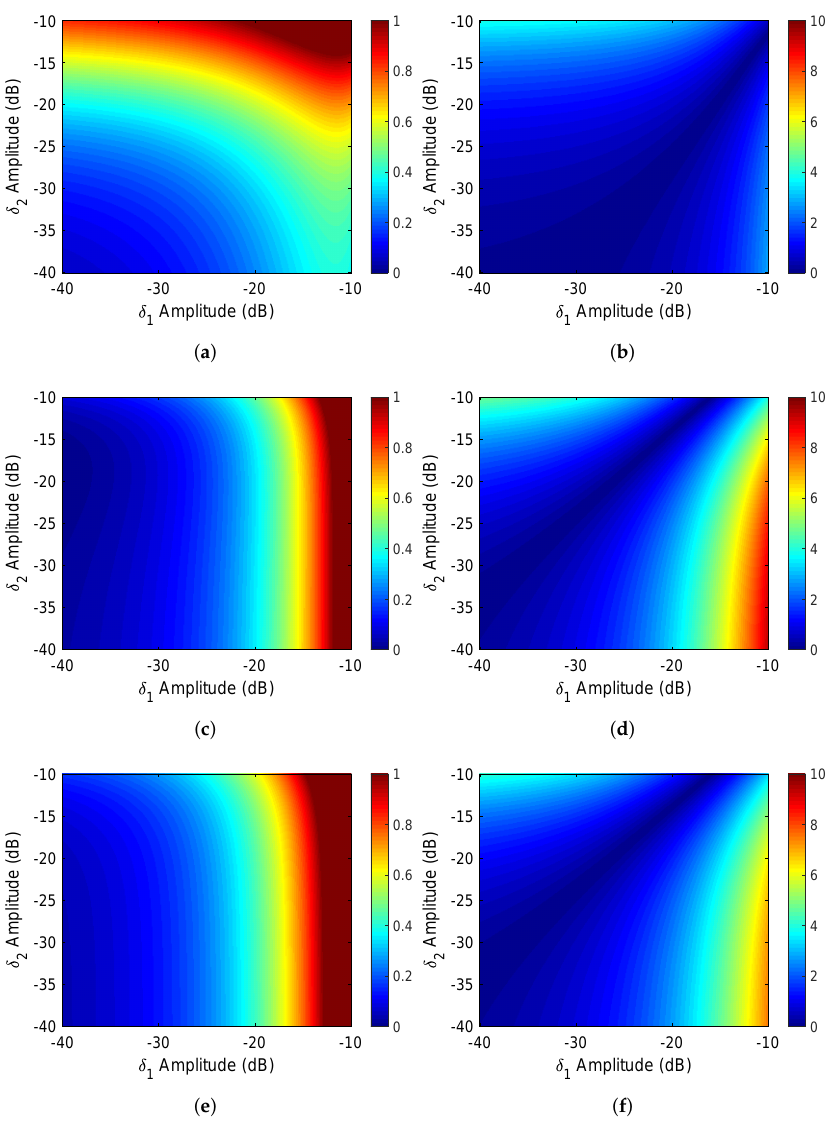
Figure 4. The amplitude and phase coefficients estimation error of the ICT calibration scheme under different crosstalk levels. The first column is the amplitude coefficient estimation error, and the second column is the phase coefficient estimation error. ( a , b ) are estimation errors of trihedral ( A 1 , φ 1 ). ( c , d ) are estimation errors of dihedral ( A 2 , φ 2 ). ( e , f ) are estimation errors of 22.5 ◦ rotated dihedral ( A 3 , φ 3